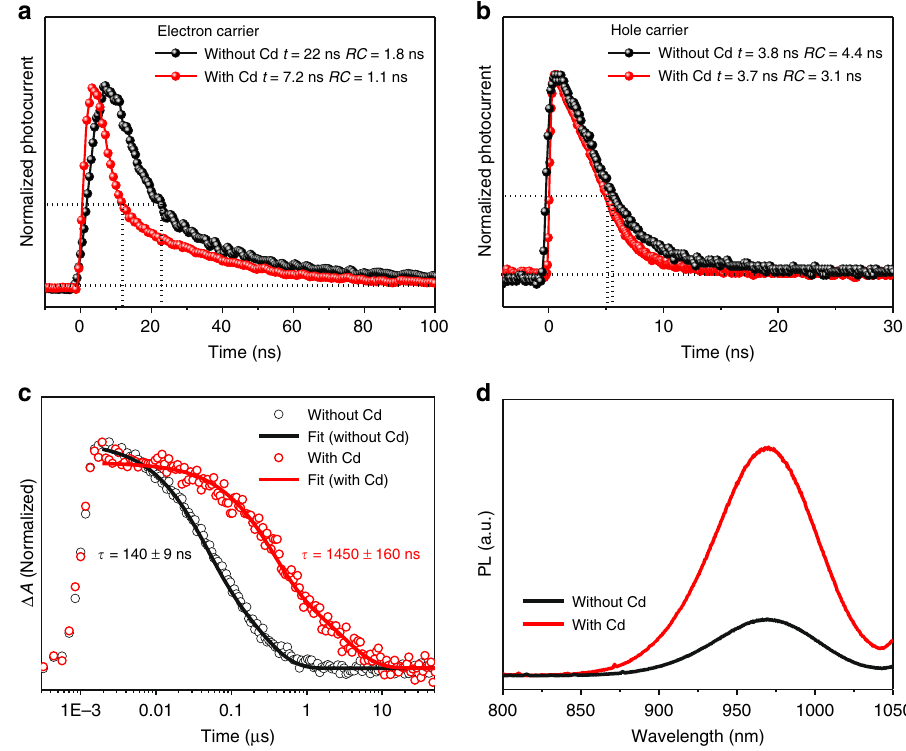
Fig. 3 In fl uence of Cd 2 + ions on the carrier properties of NBG perovskites. a and b Normalized transient photocurrent of NBG PSCs with and without Cd 2 + ions for electron ( a ) and hole ( b ) carriers. c TA kinetics near the exciton bleach (950 nm) of NBG perovskites with and without Cd 2 + ions. τ is the average lifetime described in the method. d Steady-state PL of 1000-nm-thick NBG perovskite fi lms with and without Cd 2 + ions. All studies in Fig. 3 are based on 1000-nm-thick perovskite fi lm. Source data are provided as a Source Data fi